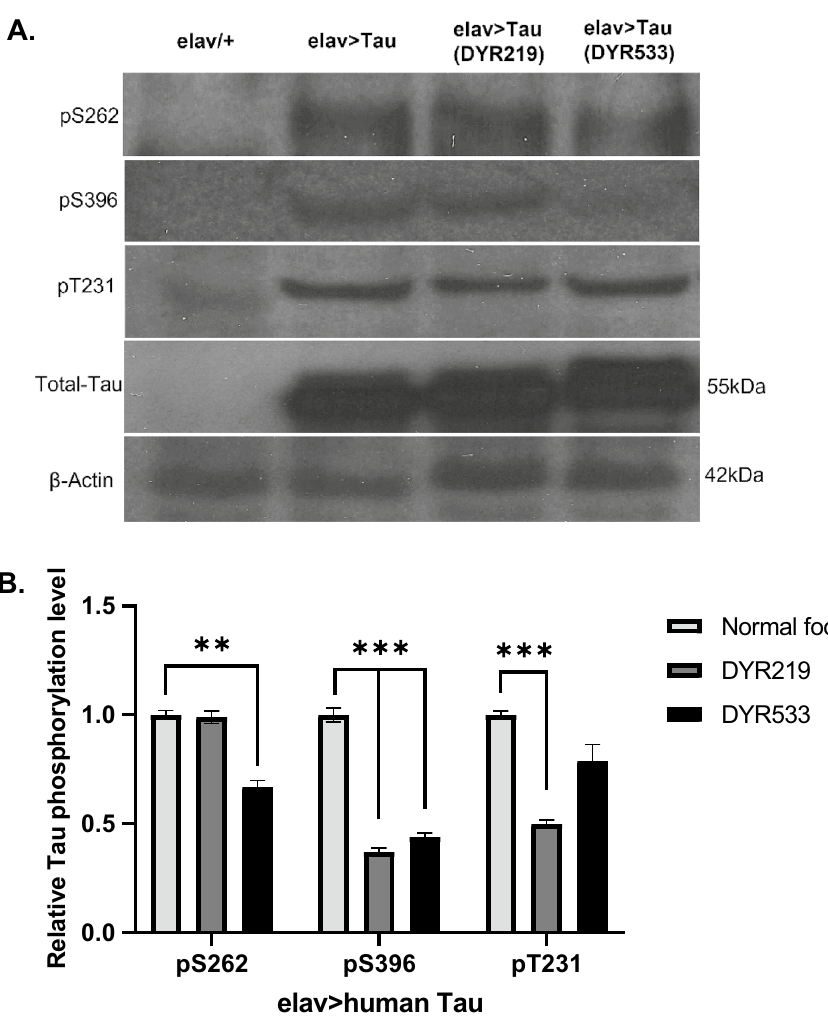
Figure 1. DYRK1A inhibitors reduced phosphorylation of human Tau expressed pan-neuronally in Drosophila . Western blots show effects of treatment with DYRK1A inhibitors (DYR219 and DYR533) on phosphorylation of human Tau 0N4R overexpressed pan-neuronally using the elav-Gal4 driver: 1st lane is Elav-Gal4/ + control, 2nd lane is Elav > human Tau 0N4R with normal food, 3rd lane is Elav > human Tau treated with 304 μM DYR219 and 4th lane is Elav > human Tau with 248 μM DYR533 treatment throughout development and adulthood (treatments were the same for all subsequent figures). Three antibodies against phosphorylated Tau (pS262, pS396 and pT231) were tested compared to the level of total unphosphorylated Tau (~ 55 kDa) using a fourth antibody. At the bottom is the β-actin protein loading control (~ 42 kDa). Supplemental Fig. S1 shows the full Westerns that the bands were imaged from. Intensity of bands are presented as mean ± Standard Error of the Mean (SEM) with data compared by 2-way ANOVA with Dunnett’s multiple comparisons test ** P < 0.01 and *** P <